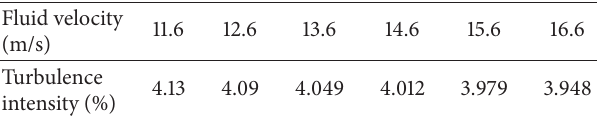
Table 2: Relation between the fluid velocity and the turbulence